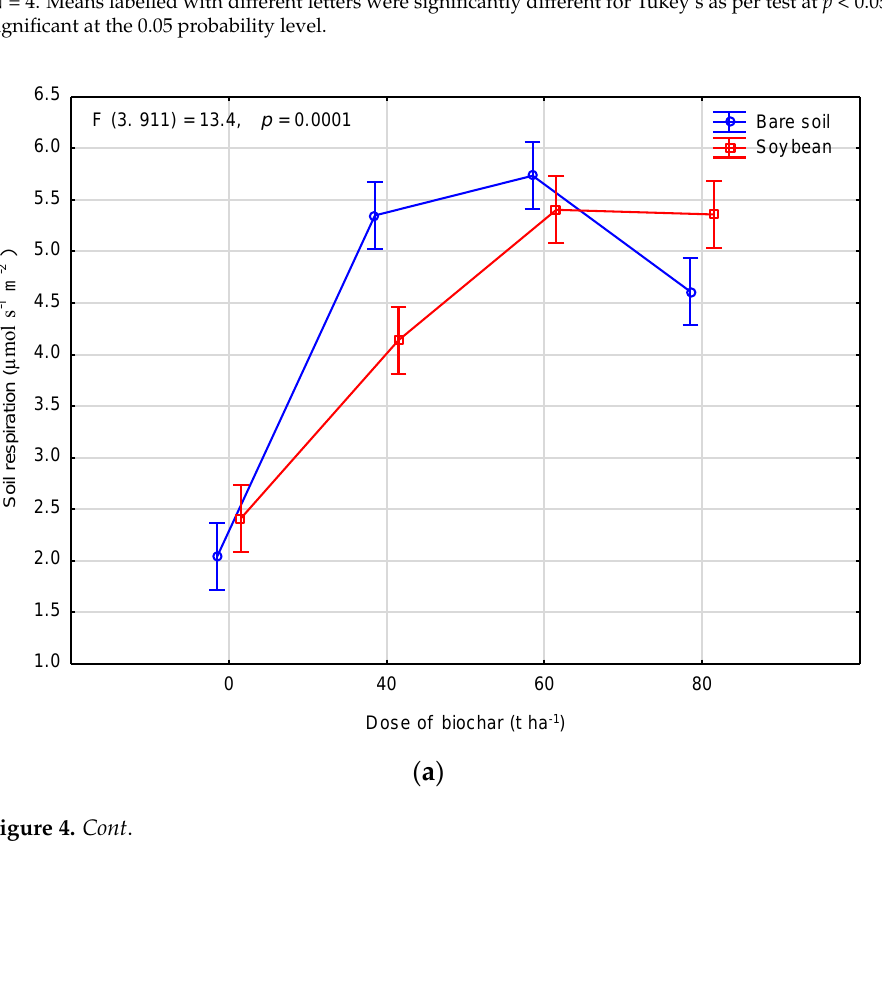
( b ) Figure 4. Effect of factor convergence on ( a ) soil respiration and ( b ) soil temperature. Table 4. Soil respiration activity, average soil temperature, and water vapor flow in the soil in the second year after biochar application, depending on the soil protection variant. Factor Soil Respiration— SR (µmol s −1 m −2 ) Soil Surface Temperature—ST (°C) H 2 O Exchange Rate (Soil Water Flux) =